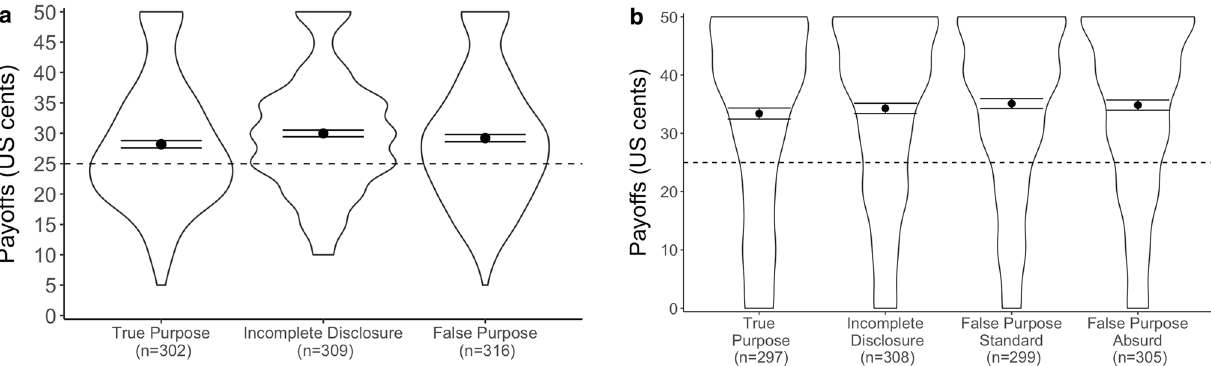
Figure 1. Actual payoffs and payoffs predicted by a fair coin (Panel a : Study 1) and die (Panel b : Study 2). Dishonesty occurred in every condition across both studies, as reflected in the skewness of distributions of reported payoffs and the averages deviating from that predicted by 10 rounds of coin flipping (Study 1) and a roll of a fair six-sided die: both USD25 cents. Differences between conditions were economically minimal and insignificant in most statistical analyses. Dots represent the average payoff for each condition. Error bars indicate standard errors of the mean. The dashed line represents the average outcome predicted by the theoretical distribution of a fair coin (Study 1) or six-sided die (Study